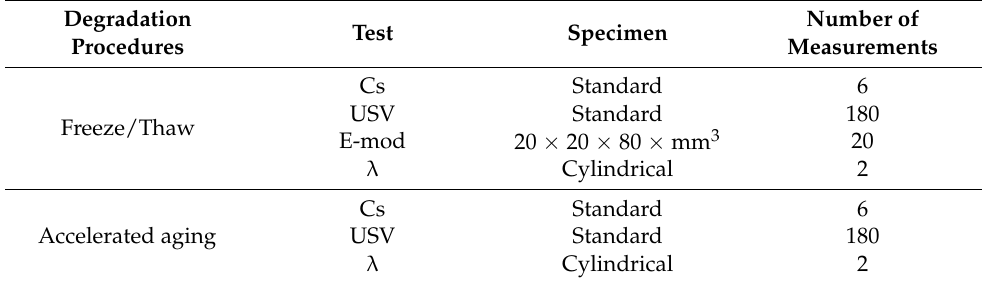
Table 7. Identification of the render samples according to lightweight aggregates.